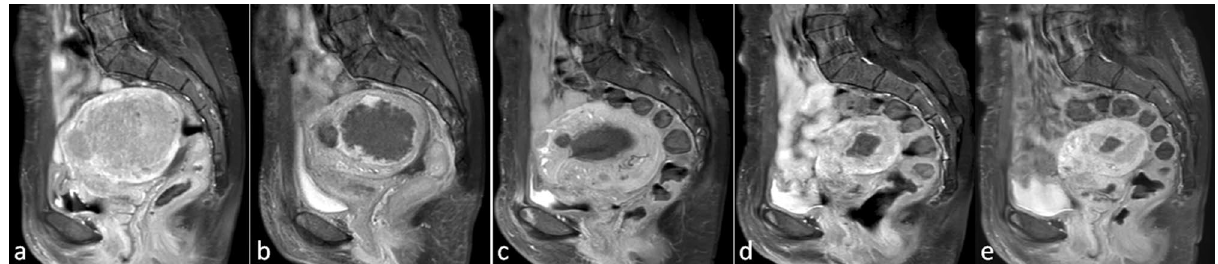
Figure 4. A 45-year old patient with symptomatic uterine fibroids presented with menstrual complaints (hyper-dysmenorrhea), urination urge, pain/pressure in the pelvic region and was treated by USgHIFU in our hospital. Three weeks after HIFU, considerable symptom relief was observed. Representative MRI-images ( a – e , contrast-enhanced T1-weighted in sagittal plane) of the largest uterine fibroid are shown over time before and after HIFU treatment: ( a ) baseline with initial fibroid size of 6.2 × 5.4 cm; ( b ) one day post-HIFU large treated region showed no contrast enhancement indicative of effective ablation ; ( c – e ) A continuous reduction in fibroid volume after HIFU-treatment was observed, this was 66.4%, 84.6% and 90.1% after 6 months, 1 and 2 years, Side effects and complications.